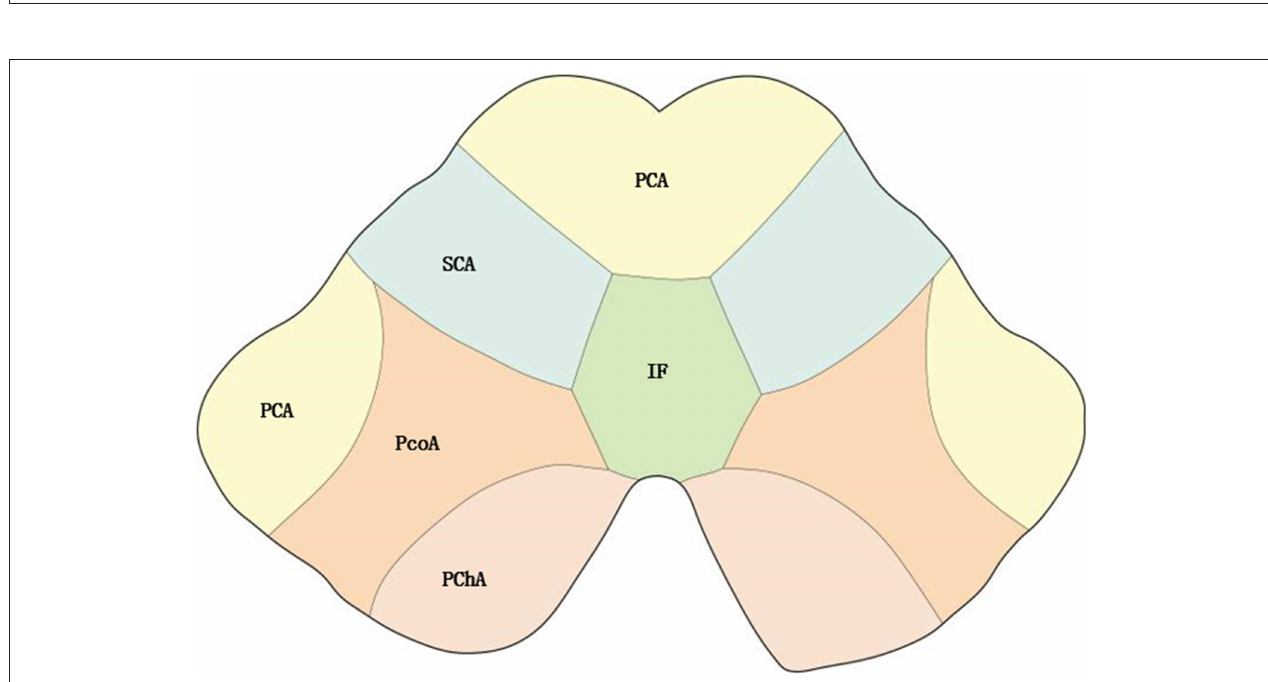
FIGURE 3 | Distribution of blood supply of the midbrain. PChA, Posterior choroidal artery; PcoA, Posterior communicating artery; IF, interpeduncular fossa.